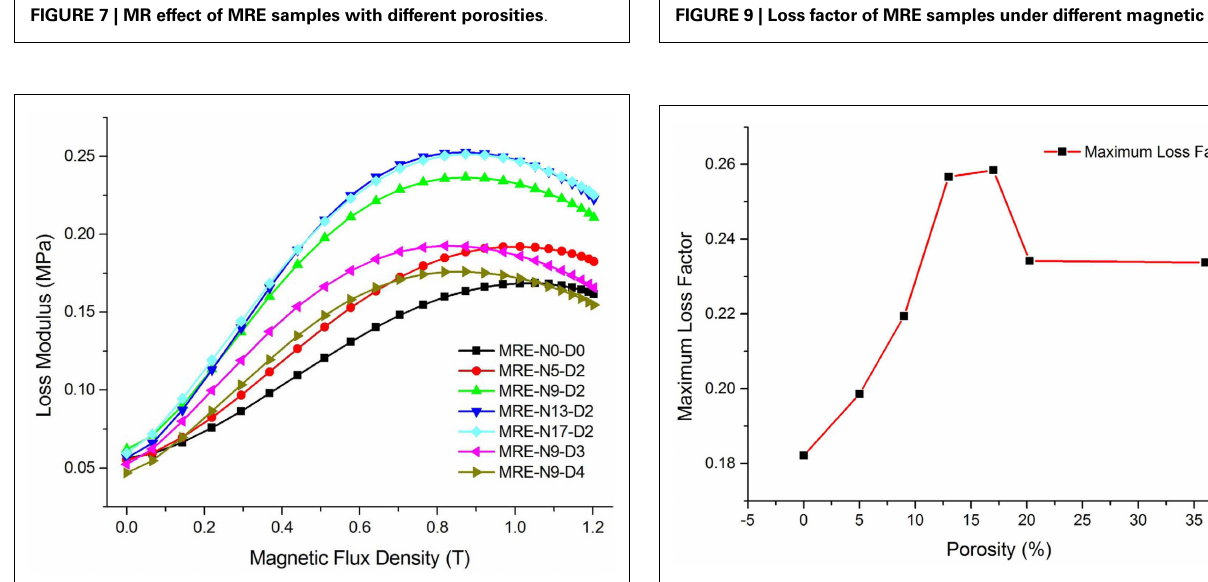
FIGURE 10 | Maximum loss factor for different porosities under magnetic field